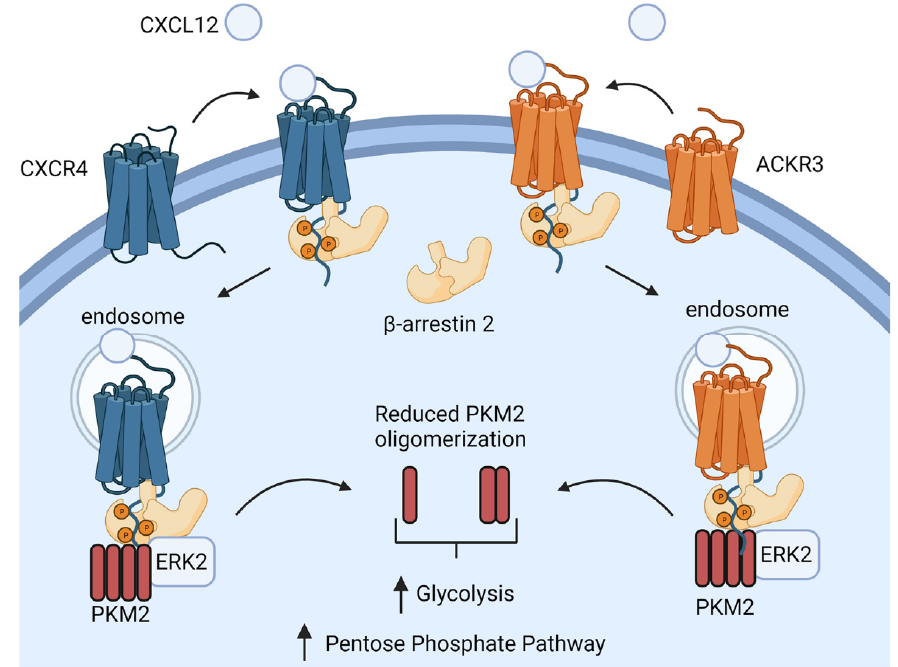
Figure 9. Summary of protein interactions from CXCL12 signaling to PKM2. CXCL12 binding to CXCR4 or ACKR3 triggers the recruitment of β‐ arrestin 2 and endocytosis of the receptor. ERK2 interacts with β‐ arrestin 2 and PKM2. PKM2 subsequently dissociates from β‐ arrestin 2 with PKM2, showing reduced oligomerization. We measure shifts from PKM2 tetramers to dimers and monomers from reduced complementation signal for PKM2 oligomers but do not directly quantify abundance of each species associated with or released from β‐ arrestin 2. We propose that dissociation from β‐ arrestin 2 and decreased oligomerization of PKM2 contribute to observed increases in metabolites in glycolysis and the pentose phosphate pathway, driven by CXCL12. Created with BioRender.com (accessed on 28 April